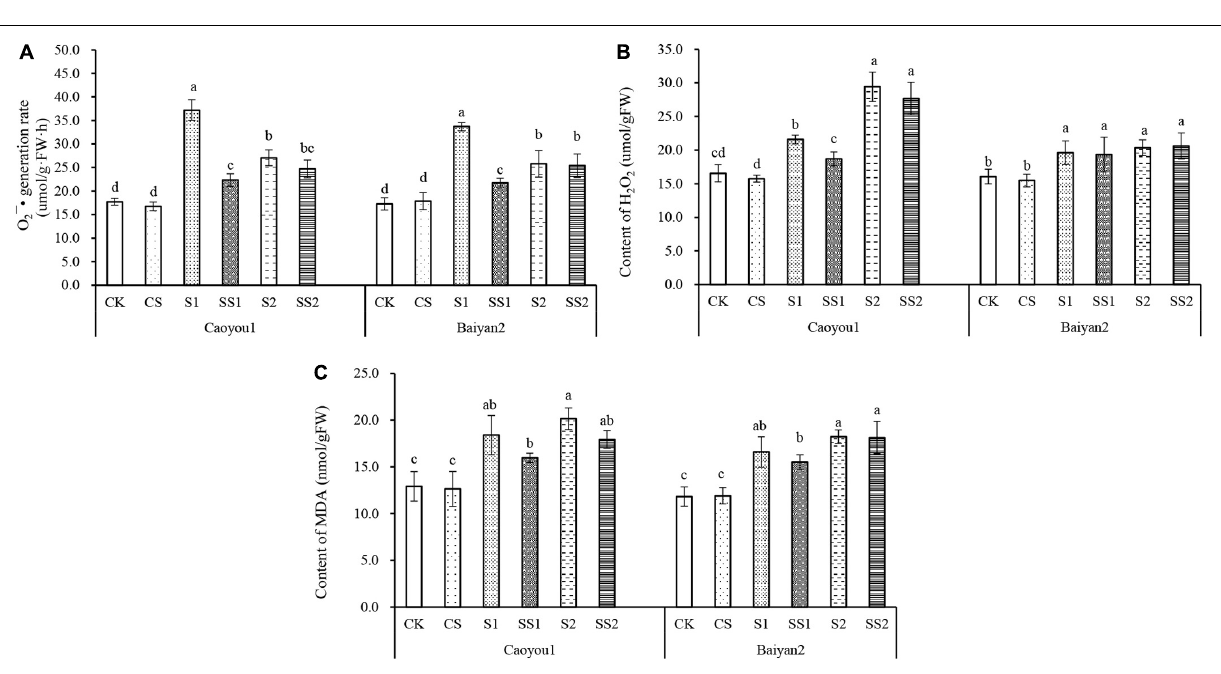
S1, Spd application (SS1) led to a significant increase in the levels of soluble protein, soluble sugar, and proline in the leaves of Caoyou 1 by 10.7, 22.8, and 10.3%, respectively. For Baiyan 2, the levels of soluble protein, soluble sugar, and